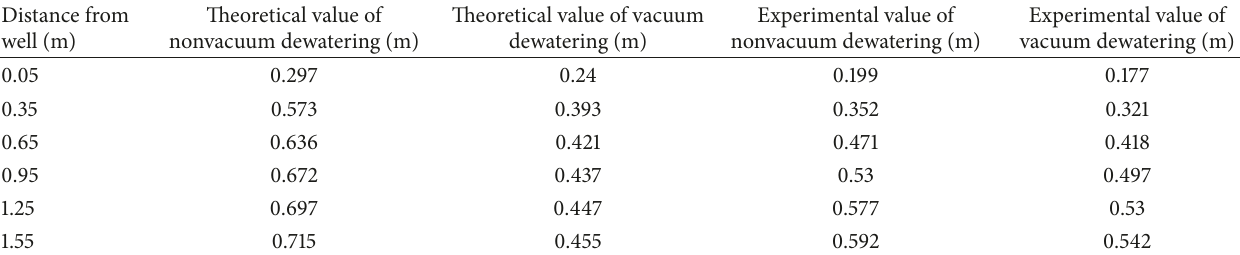
Table 3: Water level in constant flow boundary condition.